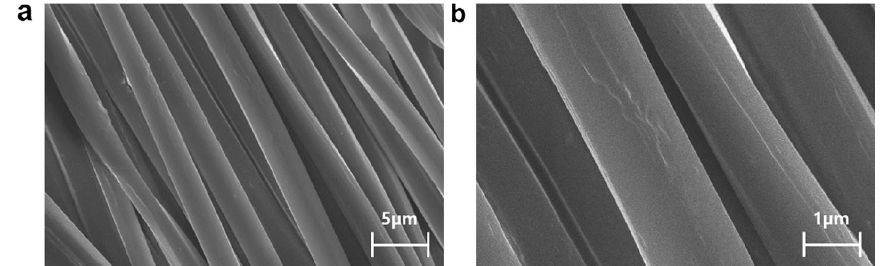
Fig. 3 FE‑SEM Image of PET fabric treated with tungsten bronze nanorods (TBNRs) 5 wt%. (Magnification a 3.2 k, b 10 × ×